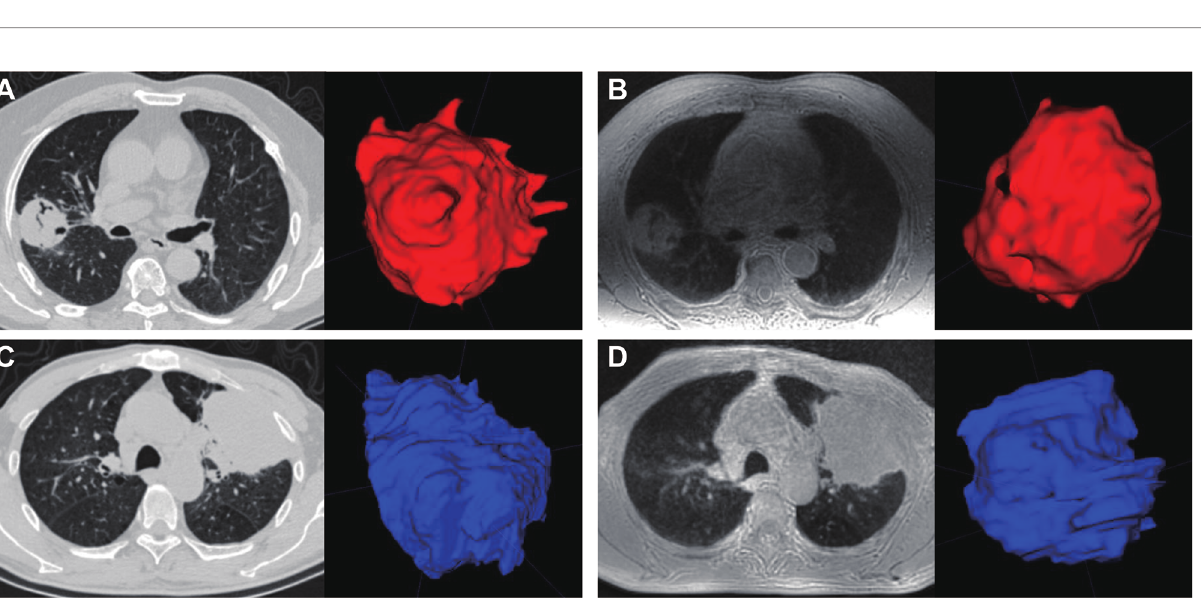
FIGURE 4 | Manual segmentation of pulmonary lesions (red or blue) using volume rendering. CT (A) and ZTE-MRI (B) in the axial view showed that the measured volumes of a lung tumor in the right upper lobe were 40.7 and 46.6 mm 3 , respectively; CT (C) and ZTE-MRI (D) in the axial view show that the measured volumes of another lung tumor in the left upper lobe were 138.8 and 145.8 mm 3 ,